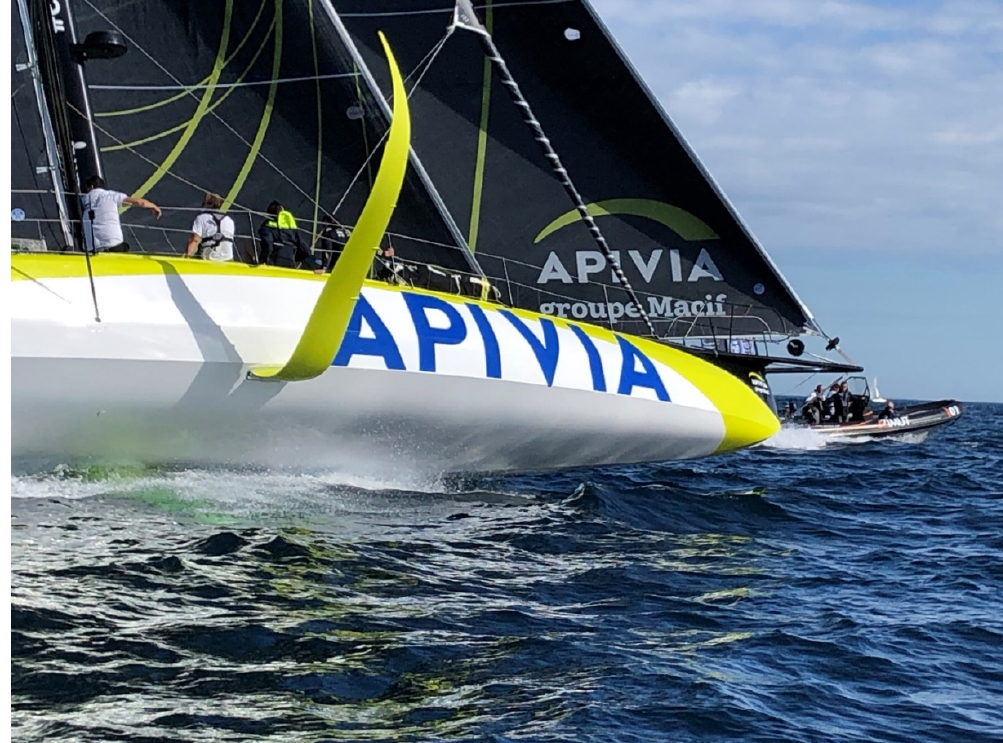
Figure 1. Photograph of IMOCA class APIVIA racing boat, the hydrofoils are manufactured using AFP technology: Photo C. Baley.